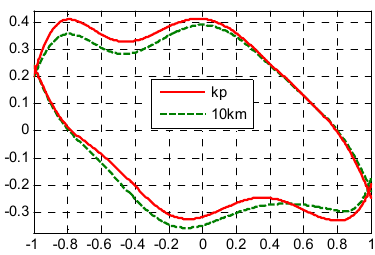
Figure 9. Propeller characteristics across four quadrants.